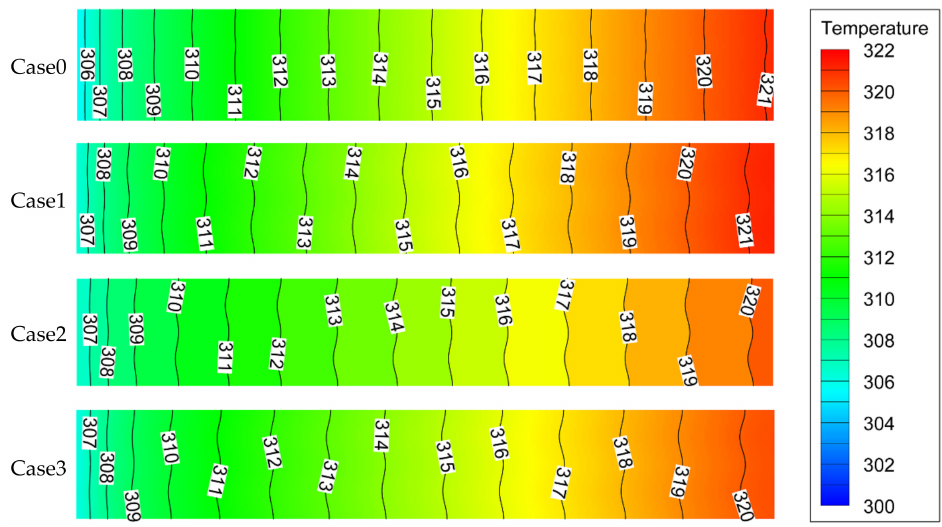
Figure 10. Temperature distribution on substrate of the four cases ( u in = 0.75